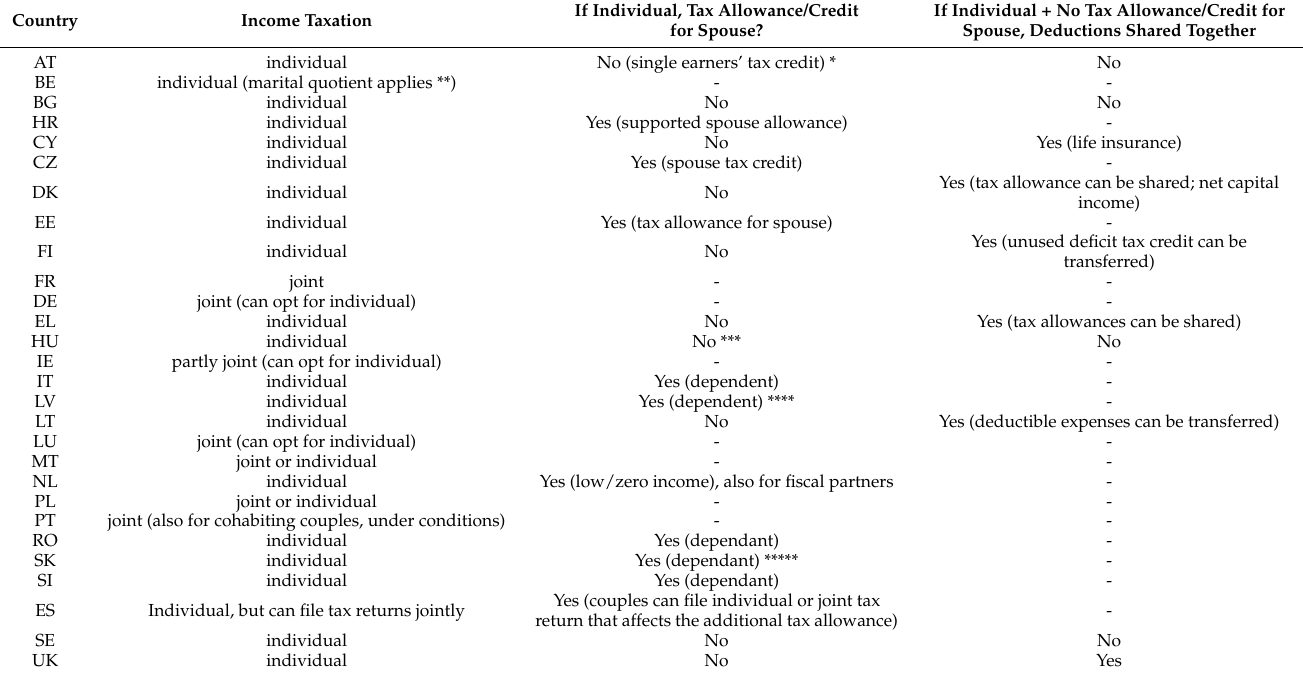
Table A1. Tax treatment of married couples across